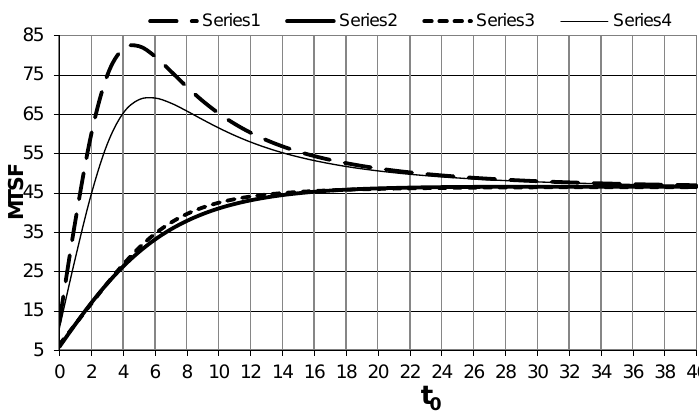
Fig. 2: The MTSF of the system based on different parameter values